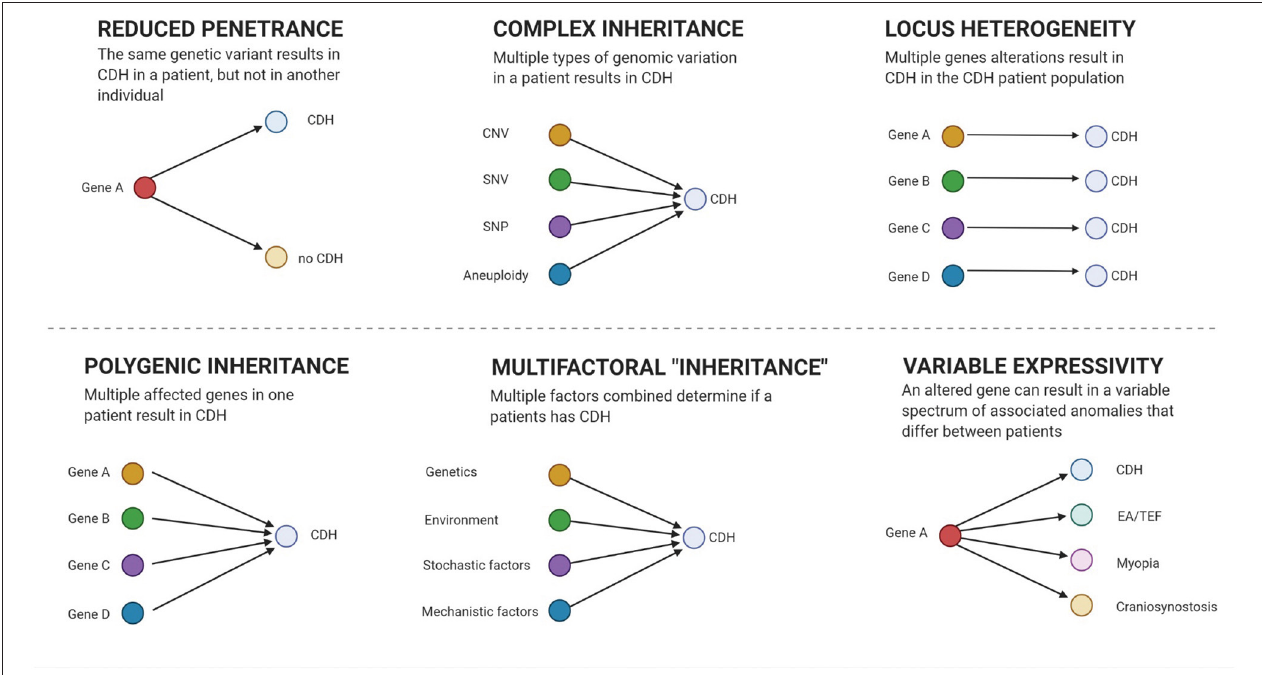
FIGURE 1 | Genetic models. Figure created with